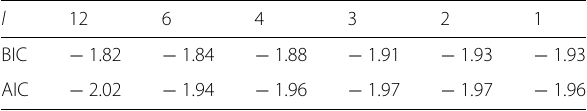
Table 1 Log number of short-time